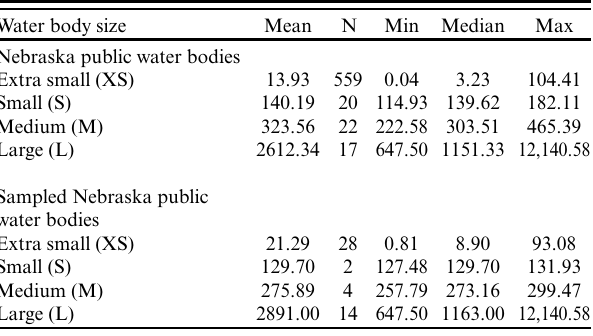
Table 1 . Characteristics for the four water body groups (extra small, small, medium, and large) identified by the discontinuity analysis on water body size (ha). Top portion is all available Nebraska public water bodies and bottom portion is the sampled water bodies.